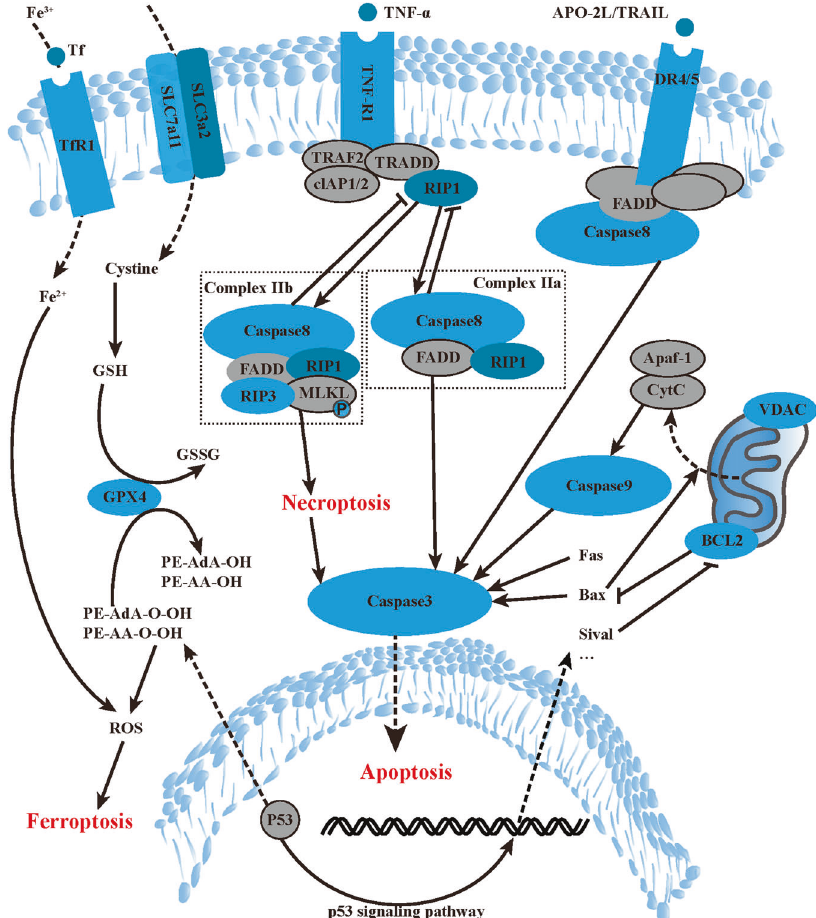
Fig. 7 Diagram of apoptosis, necroptosis, and ferroptosis pathway. During ischemia reperfusion injury, apoptosis, necroptosis and ferroptosis pathway are activated. Transferrin upregulation brings intracellular iron accumulation while cystine-transportation and GPX4 dysfunction brings phospholipids peroxidation. Finally lipid ROS increases and activates ferroptosis. TNF- α activates its receptor, resulting in formation of Complex IIa or Complex IIb, and leads to necroptosis or apoptosis respectively. Apoptosis can also originate from some other extrinsic or intrinsic signals, such as Apo2 Ligand or cytochrome c. The crosstalks among these pathways are complicated and need study